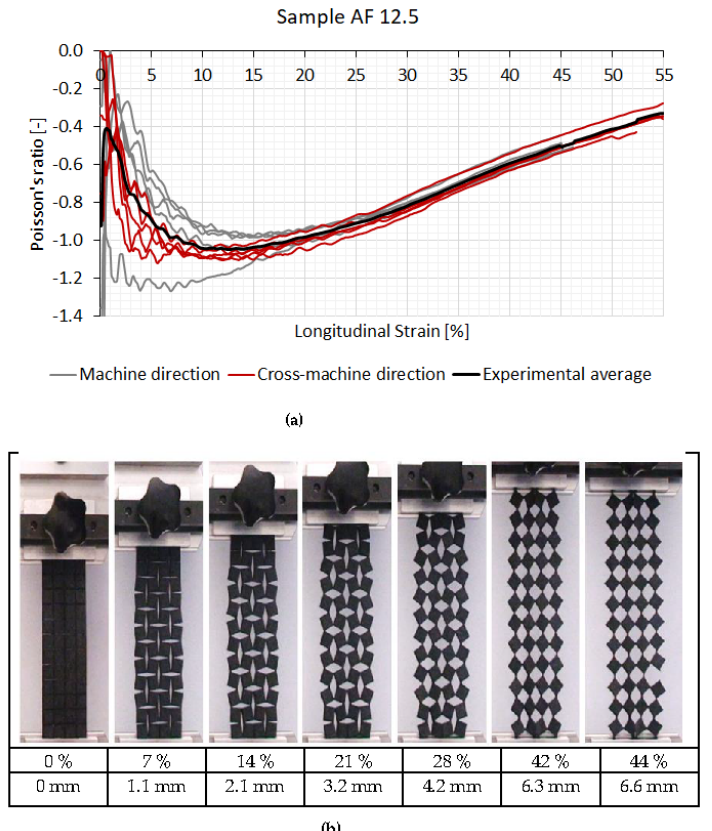
Figure 5. Poisson’s ratio of the AF 12.5 sample with the longitudinal strain ( a ) and correspond- ing fabric deformation in the machine-direction ( b ) (LS–longitudinal strain (%), LD–longitudinal displacement